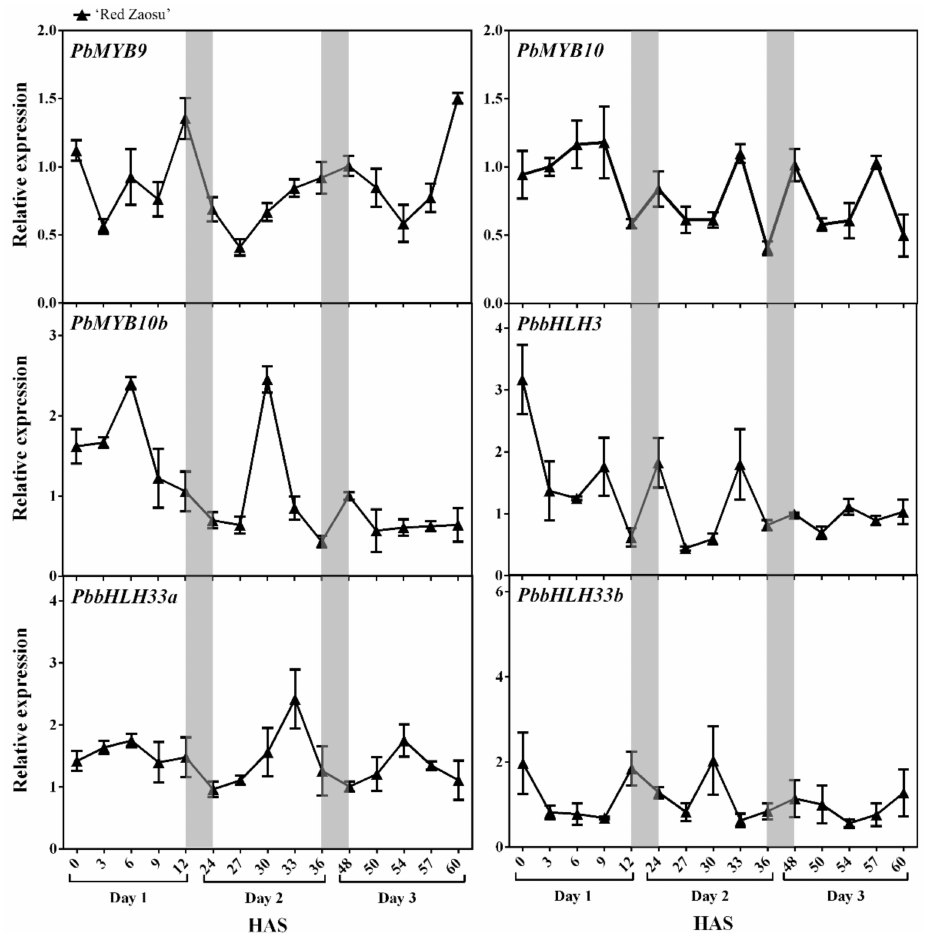
Figure 2. The expression patterns of typical anthocyanin-related transcription factors in ‘Red Zaosu’ pear fruit skin. The expression patterns of PbMYB9 , PbMYB10 , PbMYB10b , PbbHLH3 , PbbHLH33a and PbbHLH33b in ‘Red Zaosu’ fruit skin over three continuous days. The gray boxes indicate nighttime. HAS: hours after sunrise of day 1. The NCBI accession numbers of the typical transcription factors are listed in Supplementary Table S1. Error bars represent SEs of the means ( n =